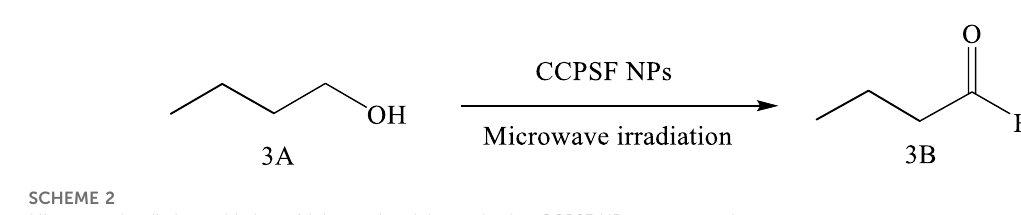
TABLE 1 Optimization conditions in the oxidation of 1-octanol to 1-octanal using CCPSF NPs as nanocatalysts under MW irradiation.